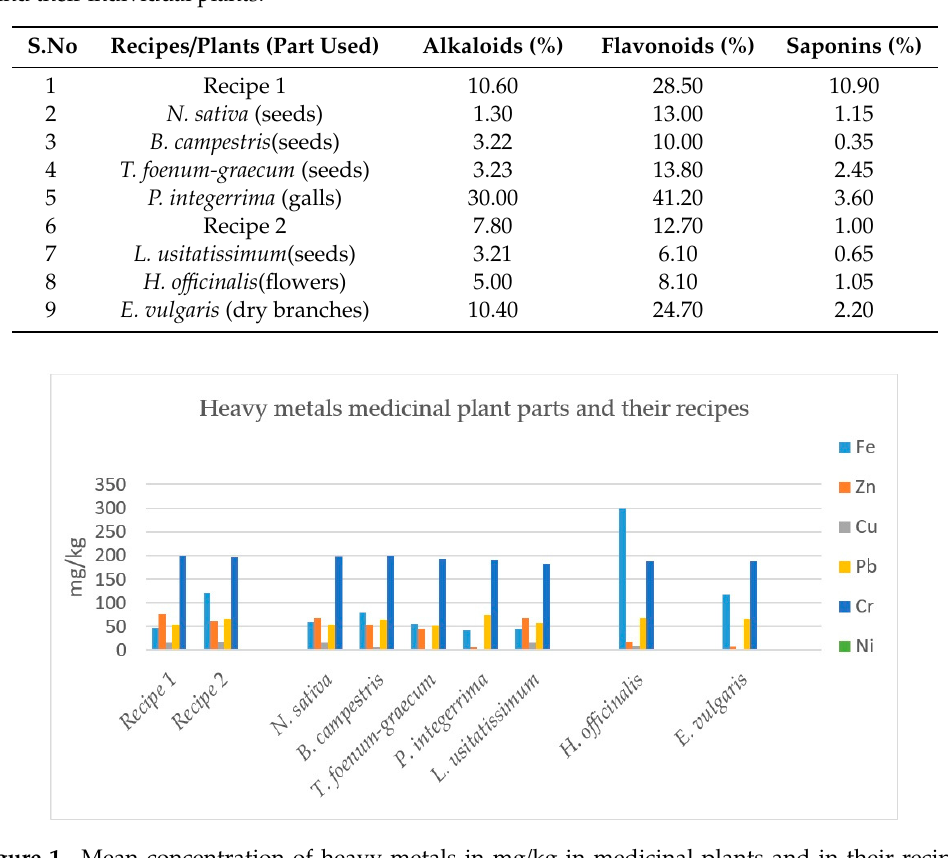
Figure 1. Mean concentration of heavy metals in mg / kg in medicinal plants and in their recipes. Each column represents mean value of three independent replicates and the error bars indicate standard deviation.